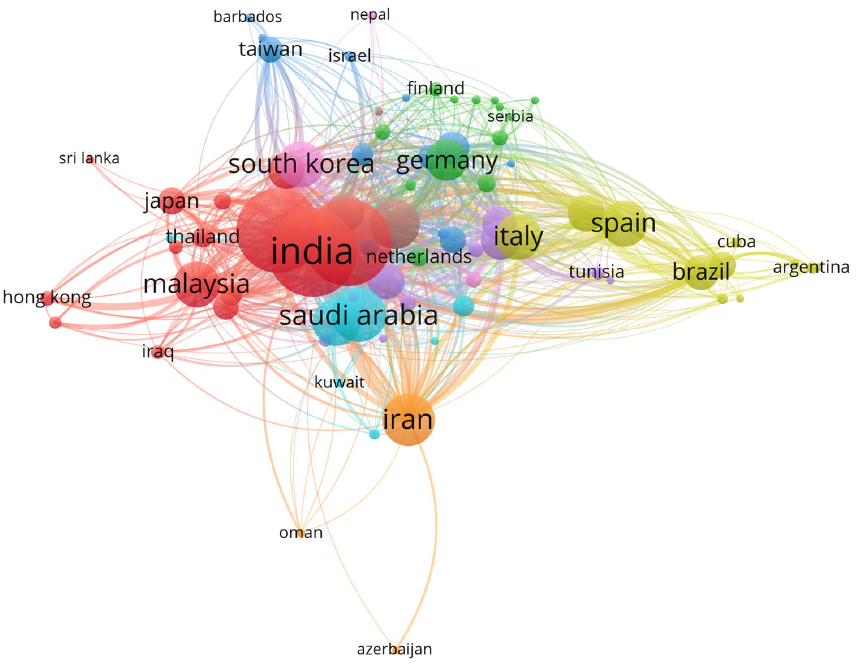
Figure 4. Country coauthorship. Based on Figure 4, India has the largest node because of the highest total link strength. The thickest line spans from China to the United States with a link strength of 120. China and the United States collaborate the most in this domain. The colors of the nodes and lines represent the clustering of the countries [73]. There are nine clusters in total. The first cluster, which is red, has 15 countries made up of Australia, China, Hong Kong, India, Indonesia, Iraq, Japan, Malaysia, Nigeria, Singapore, South Africa, Sri Lanka, Thailand, the United States, and Vietnam. The second cluster, which is green, consists of